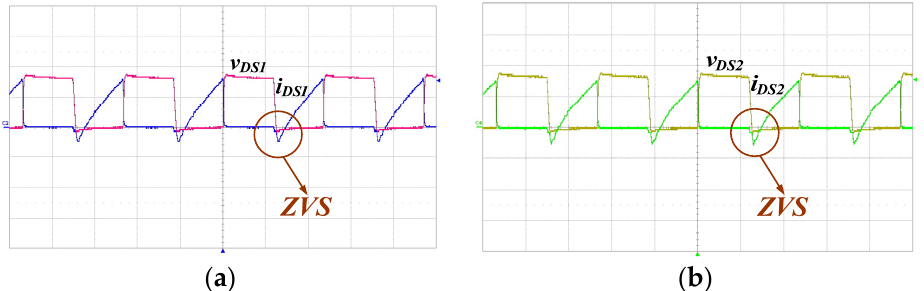
Figure 10. ( a ) Measured voltage v DS 1 (200 V/div) and current i DS 1 (1 A/div); time scale: 5 μ s/div; ( b ) Measured voltage v DS 2 (200 V/div) and current i DS 2 (1 A/div); time scale: 5 μ s/div.